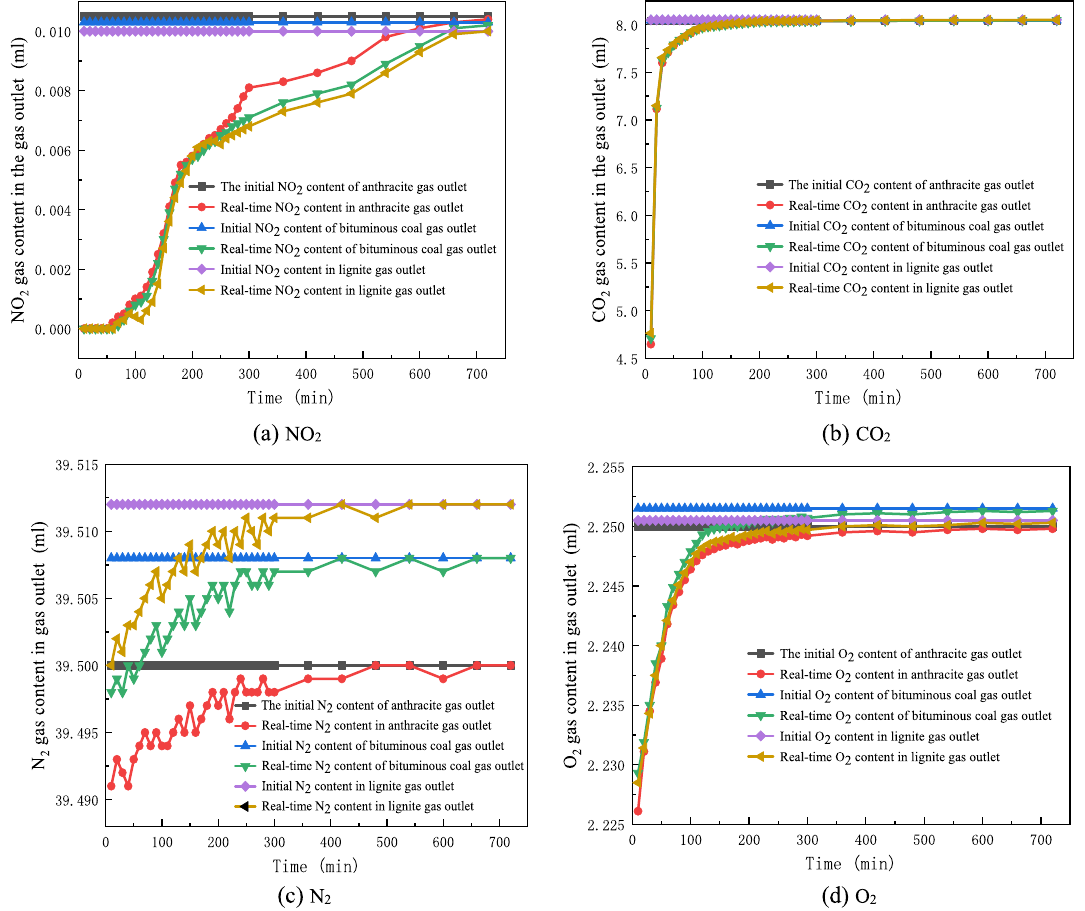
Figure 7. Change of gas content at the outlet of each coal sample with